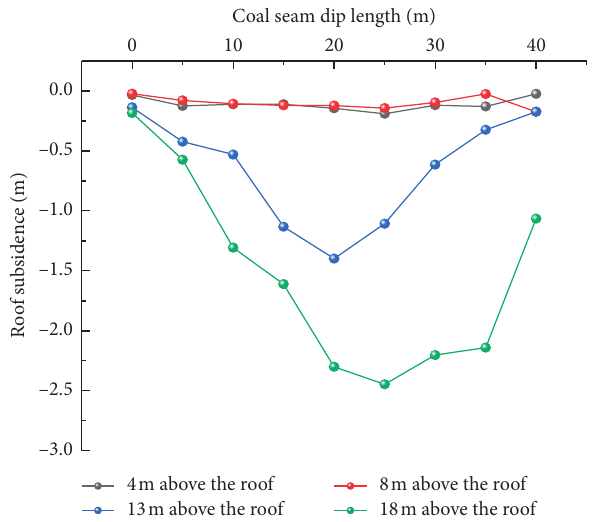
Figure 5: Displacement curve of the roof measuring point after mining (20 (m)).